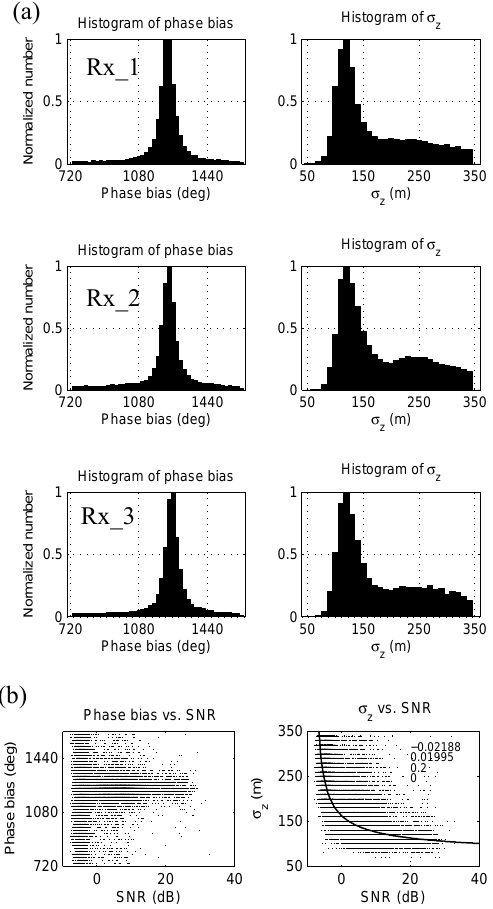
Figure 1. (a) Histograms of the calibrated parameters for three in- Figure 1: (a) Histograms of the calibrated parameters for three independent dependent receiving channels. Phase bin is 20 ◦ , and σ z bin is 10m. The shapes and sizes of the three receiving arrays are the same. receiving channels. Phase bin is 20 o and  bin is 10 m. The shapes and sizes of the z (b) Scatterplot of the calibrated parameters vs. SNR for the sec- ond receiving channel (Rx_2). The curve describing the relation- three receiving arrays are the same. (b) Scatter plot of the calibrated parameters vs. ship between σ z and SNR is a fitting curve for correcting the RIM- SNR for the second receiving channel (Rx_2). The curve describing the relationship produced brightness. Data time: 06:49:27–08:49:47UT, 9 Novem- ber between  and SNR is a fitting curve for correcting the RIM-produced brightness. z Data time: 06:49:27 UT – 08:49:47 UT, 9 November 2009.